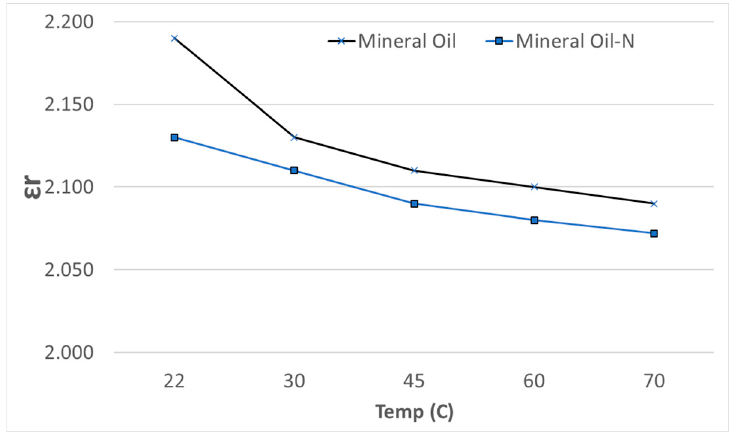
Figure 7. Variation of 𝜺 𝒓 as a function of temperature. Table 3. Breakdown voltage ( kV rms ) of oil samples as a function of